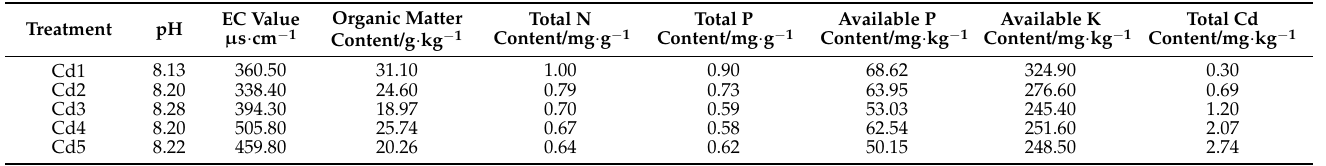
Table 2. Initial physical and chemical properties of the experiment soil.